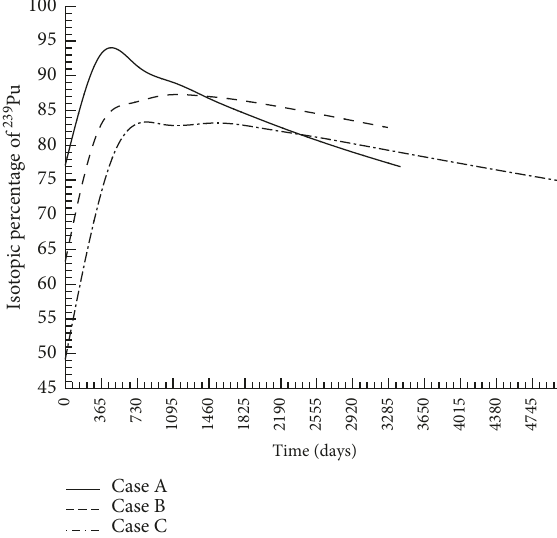
Figure 6: Variation of percentage of 239 Pu isotope in plutonium during the operation